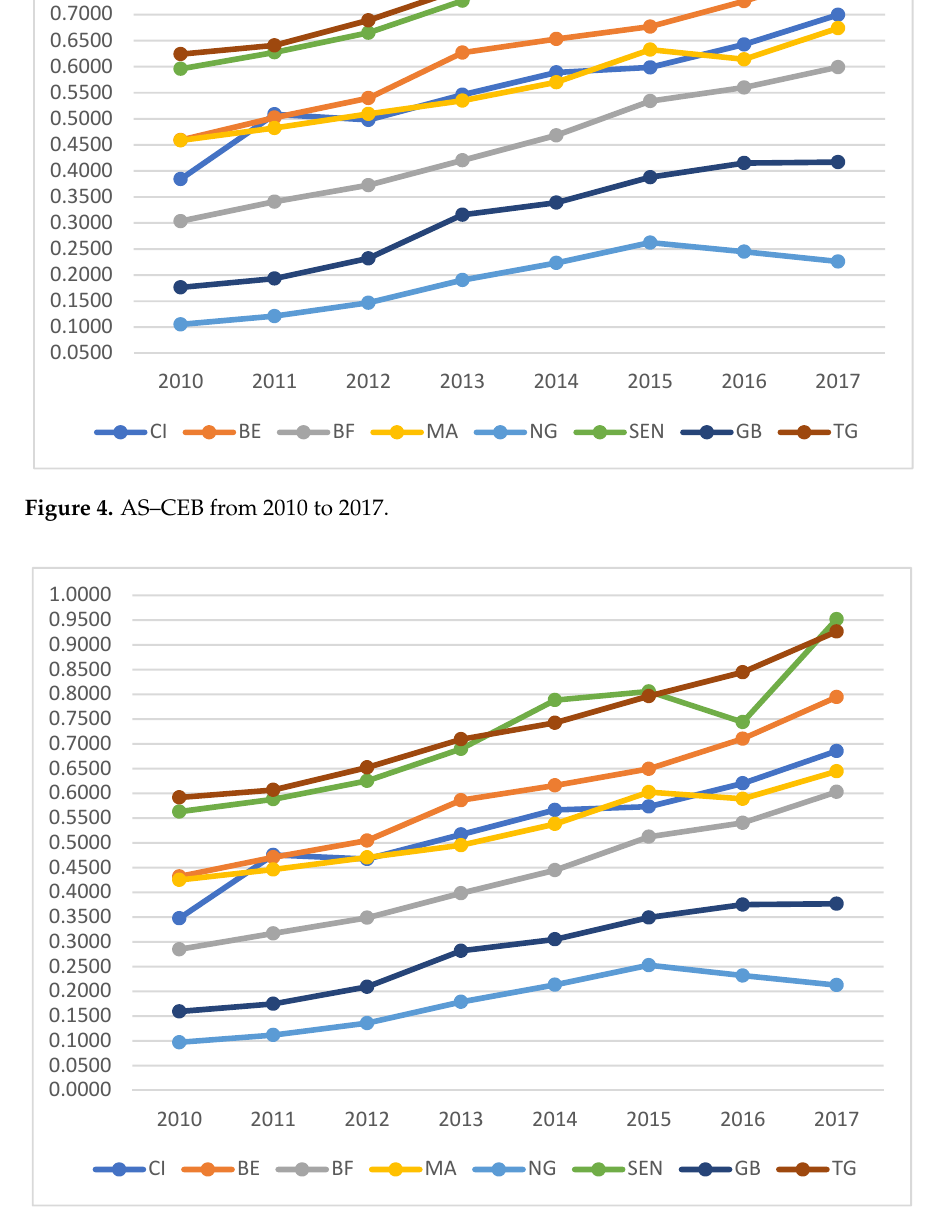
Figure 4. AS–CEB from 2010 to 2017.